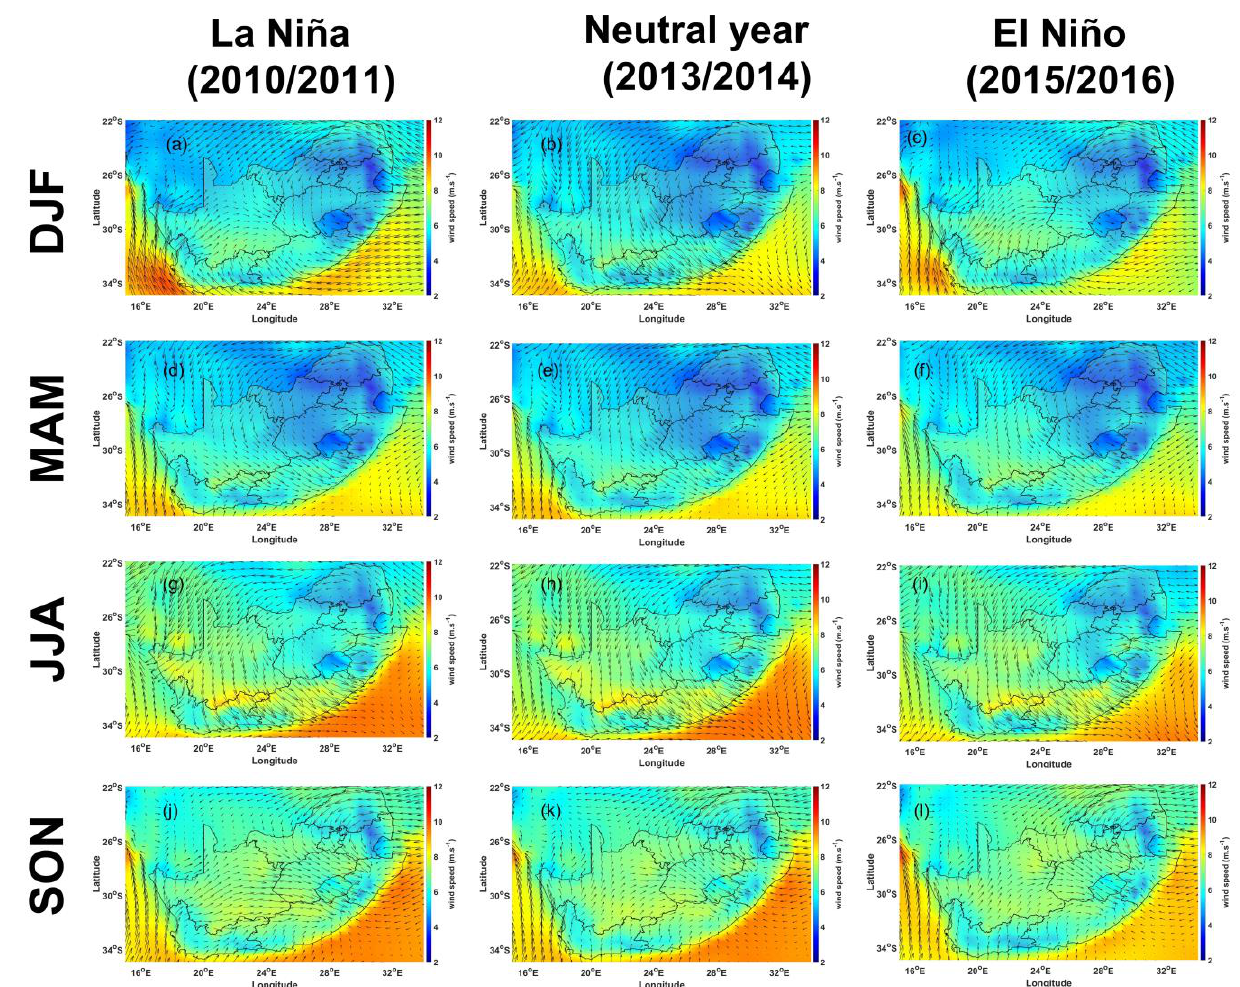
Figure 6. Seasonal mean spatial distribution of winds during the La Niña ( a , d , g , j ), neutral ( b , e , h , k ), and El Niño periods ( c , f , i , l ).